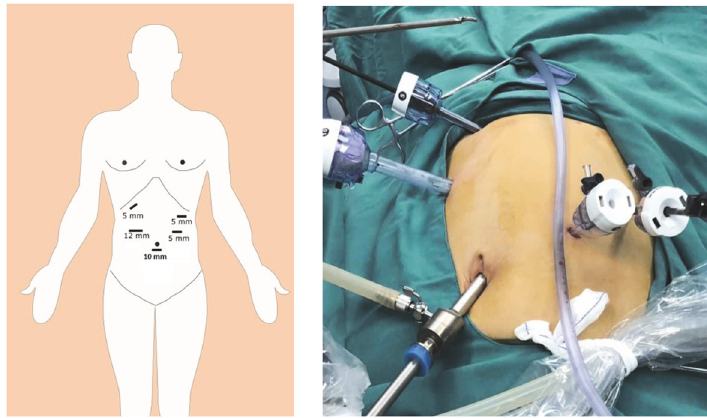
Figure 1: Placement of trocar for laparoscopic spleen-preserving distal pancreatectomy (LSPDP).